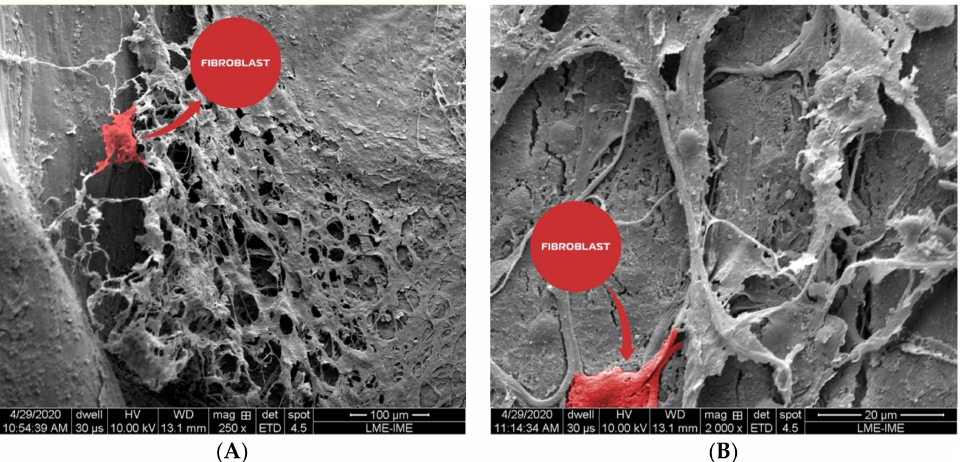
Figure 11. Photomicrographs showed the collagen fibrils that could be observed alone or in conjunction with other types of matrix proteins. They formed a reticular structure mainly on the matrix borders. An active fibroblast was observed in ( A ), (bone xenograft) and ( B ) (nano-hydroxyapatite / beta-tricalcium phosphate